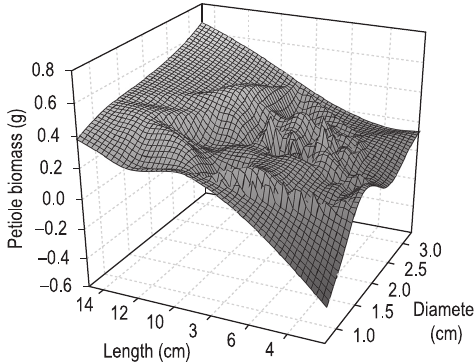
Figure 2. Graphic representation from the diameter x length x biomass for petiole